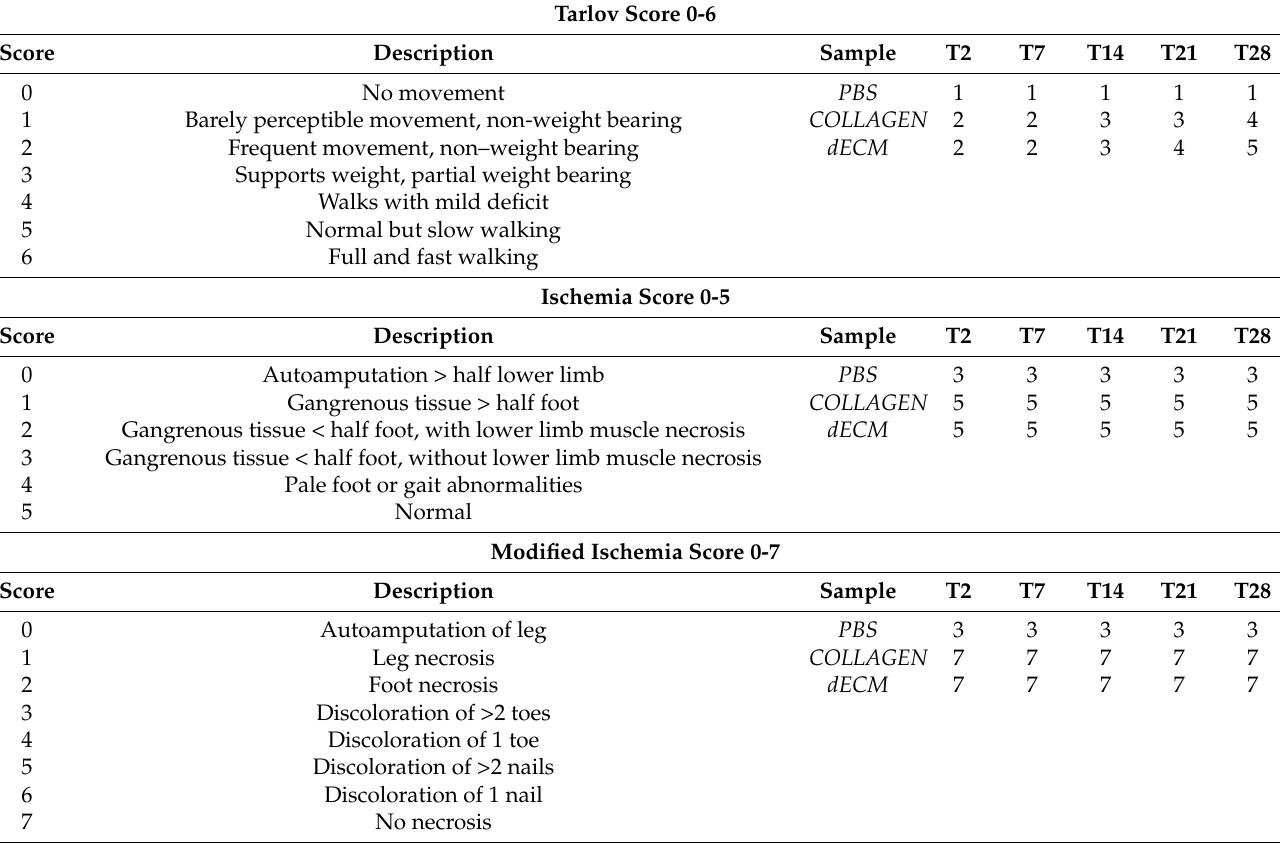
Table 3. Functional score of the mice is shown for PBS 1X, collagen and 4 mg/mL dECM hydrogel conditions. The score was assessed visually at time points of 2, 7, 14, 21 and 28 days after treatment. Score values and meanings are also given, according to the functional scoring system reported by Brenes et al. Tarlov Score